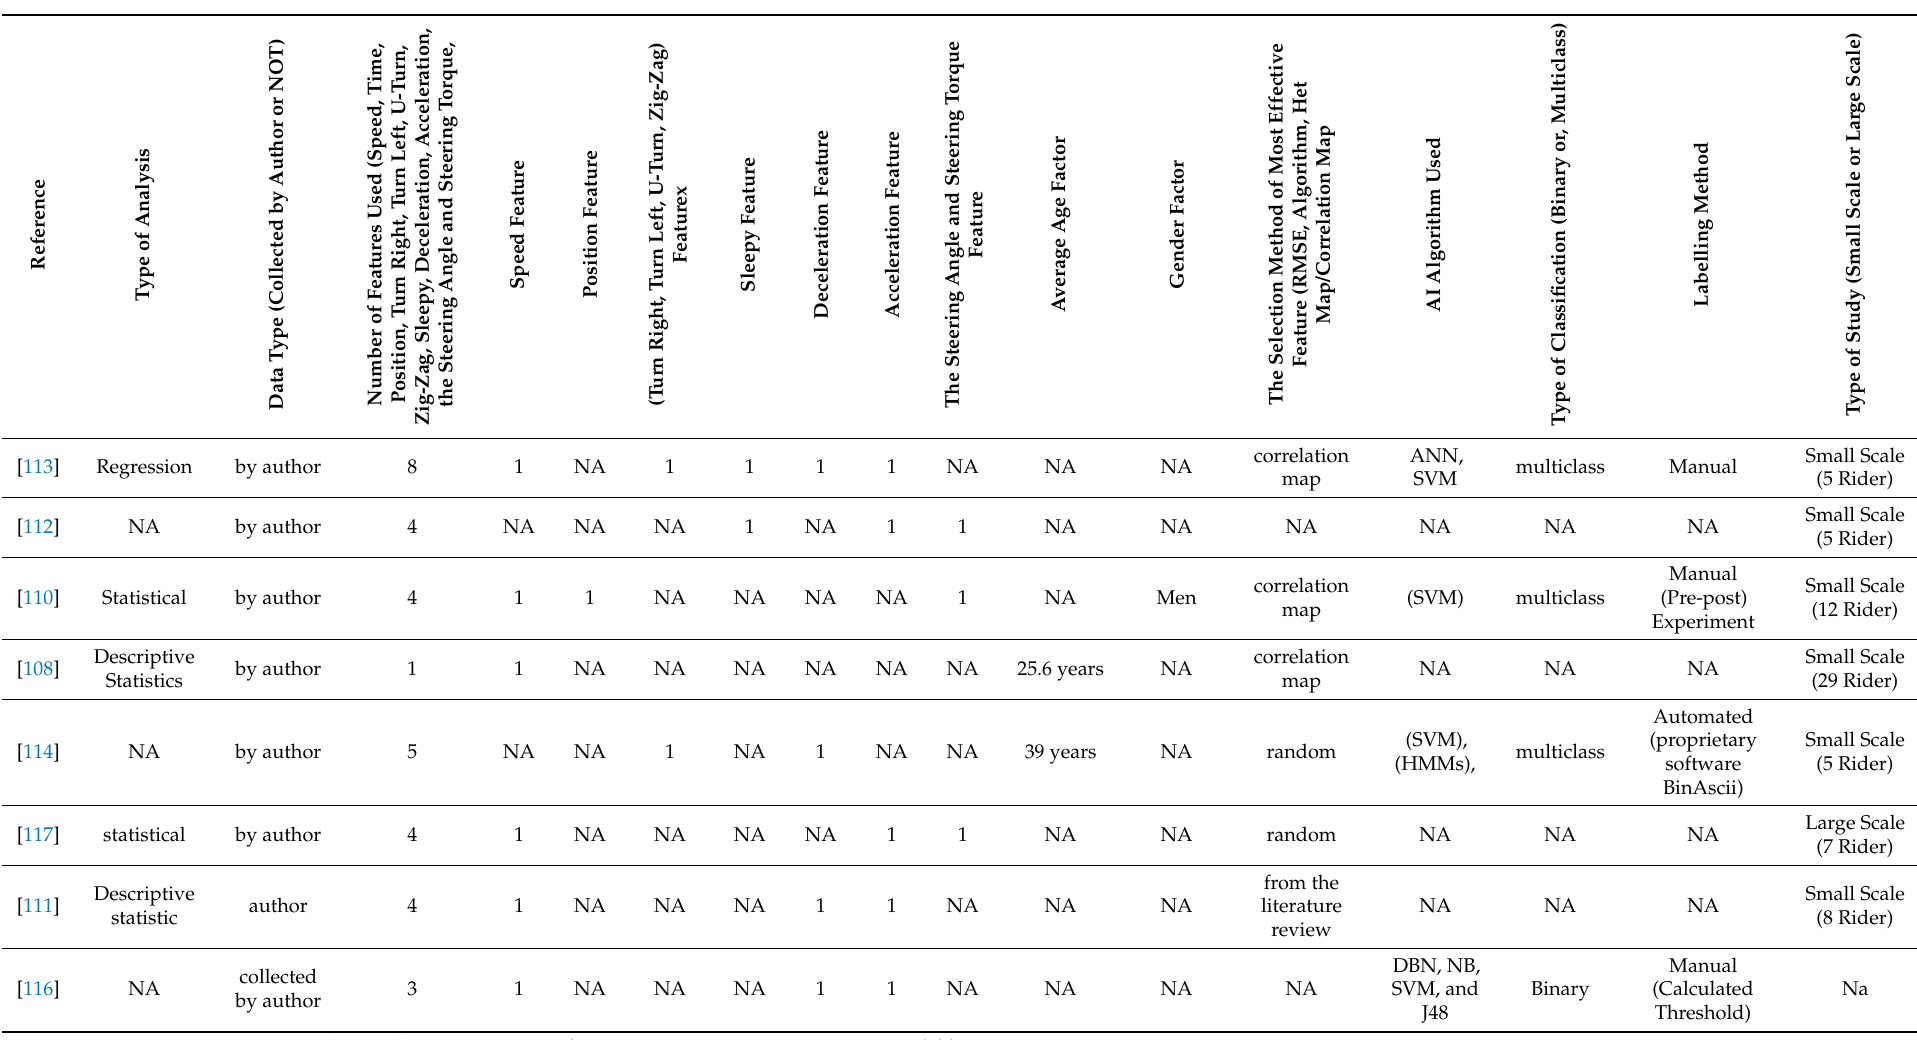
Table 3. Type of analysis for real-time